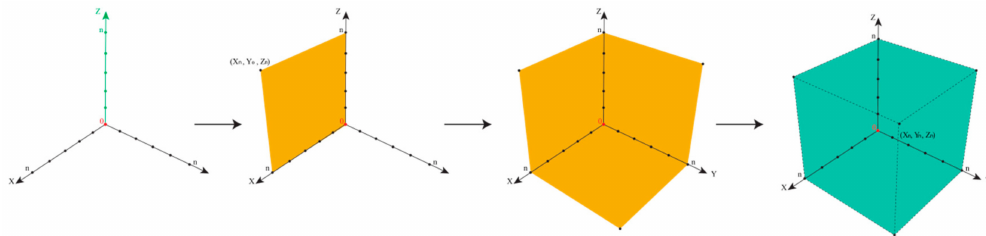
Figure 6. Illustration of dioxin impurity in Agent Orange (see text for details) .